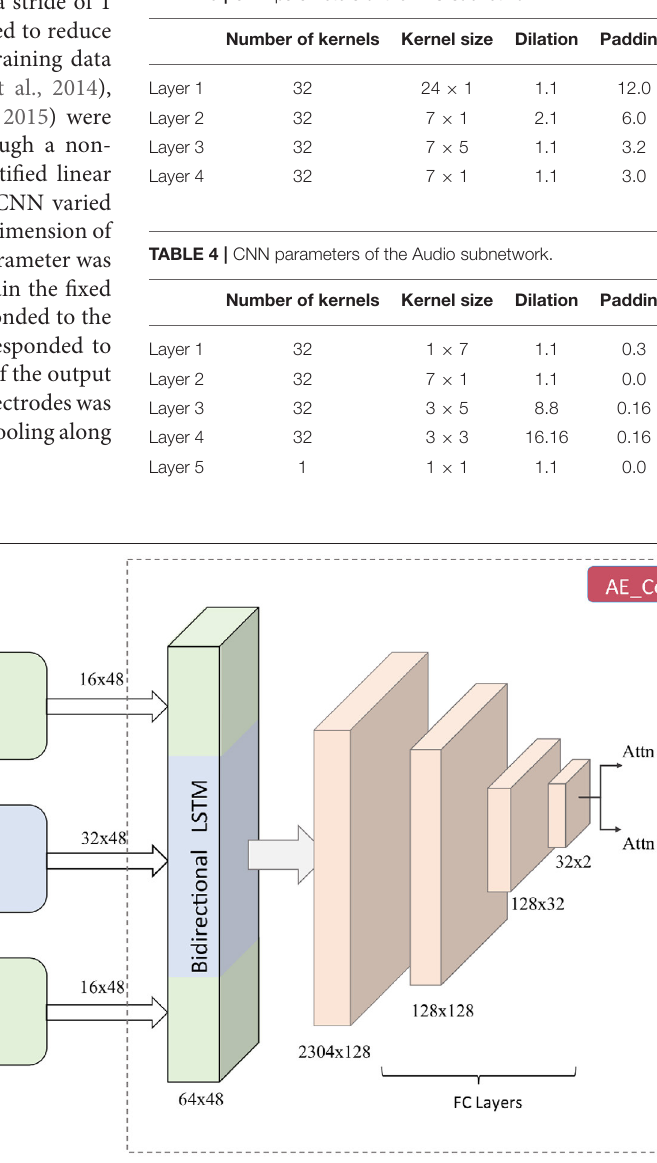
Frontiers in Physiology |